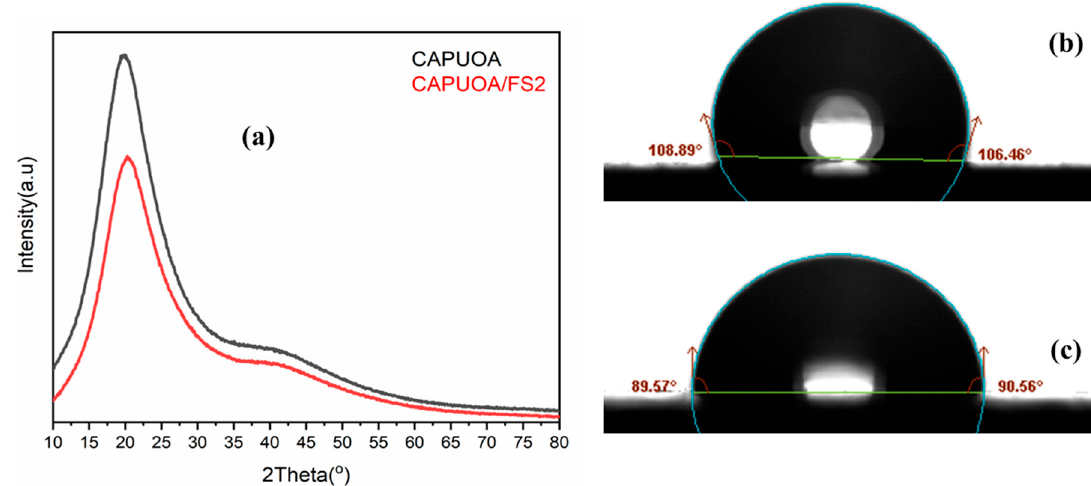
Figure 4. XRD ( a ) and Contact angle of CAPUOA ( b ) and CAPUOA/FS2 ( c ).